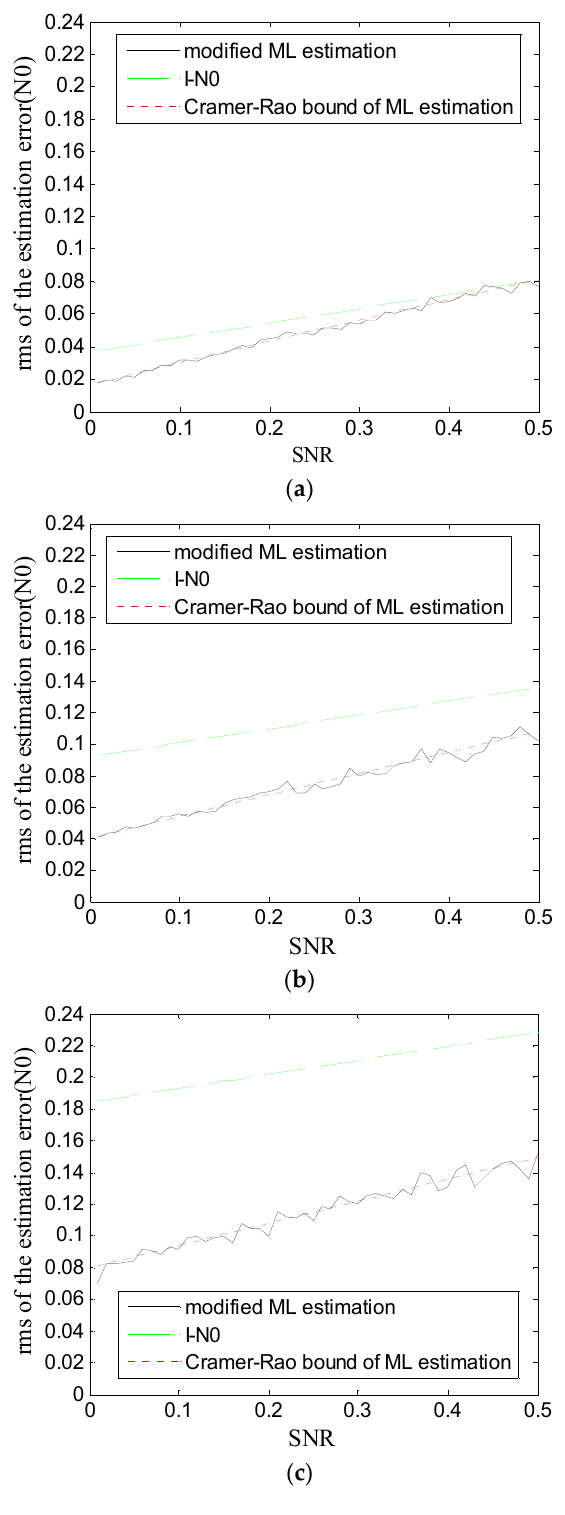
Figure 13. The comparison of three kinds of estimation precision, rms of estimation error of modified estimation method (black solid line), I − N 0 (green dashed line), and Cramer–Rao bound of maximum likelihood (ML) estimation (red dotted line), ( a ) for simulation 1; ( b ) for simulation 2; and ( c ) for simulation 3.